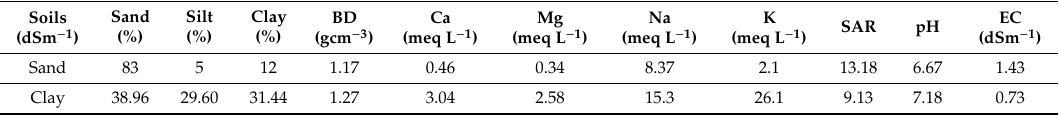
BD: bulk density, SAR: sodium absorption ratio, EC: electrical conductivity.